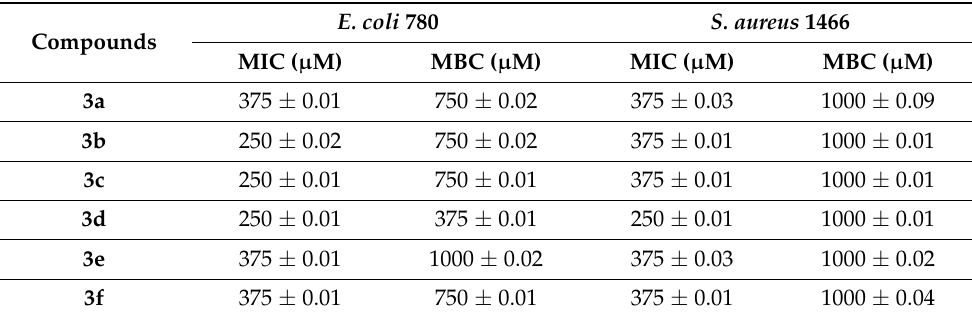
Table 3. Antibacterial activities of the compounds 3a – f